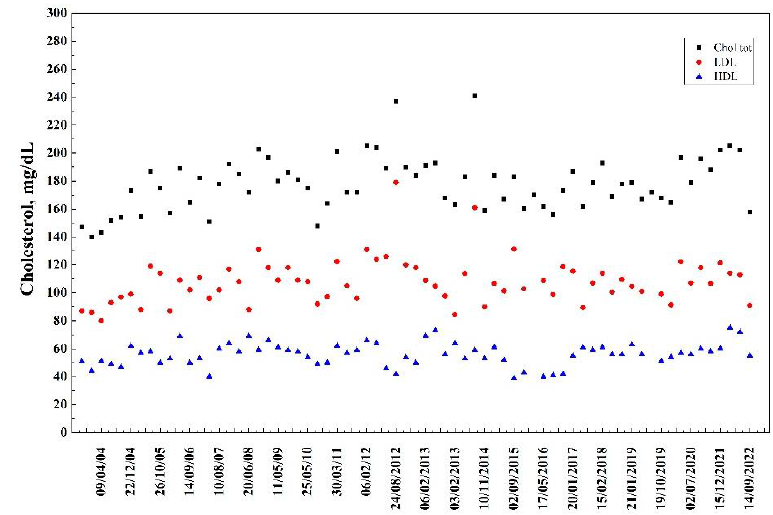
Figure 3. Evolution of total cholesterol, HDL and LDL values during the patient’s 21 years of insulin therapy.